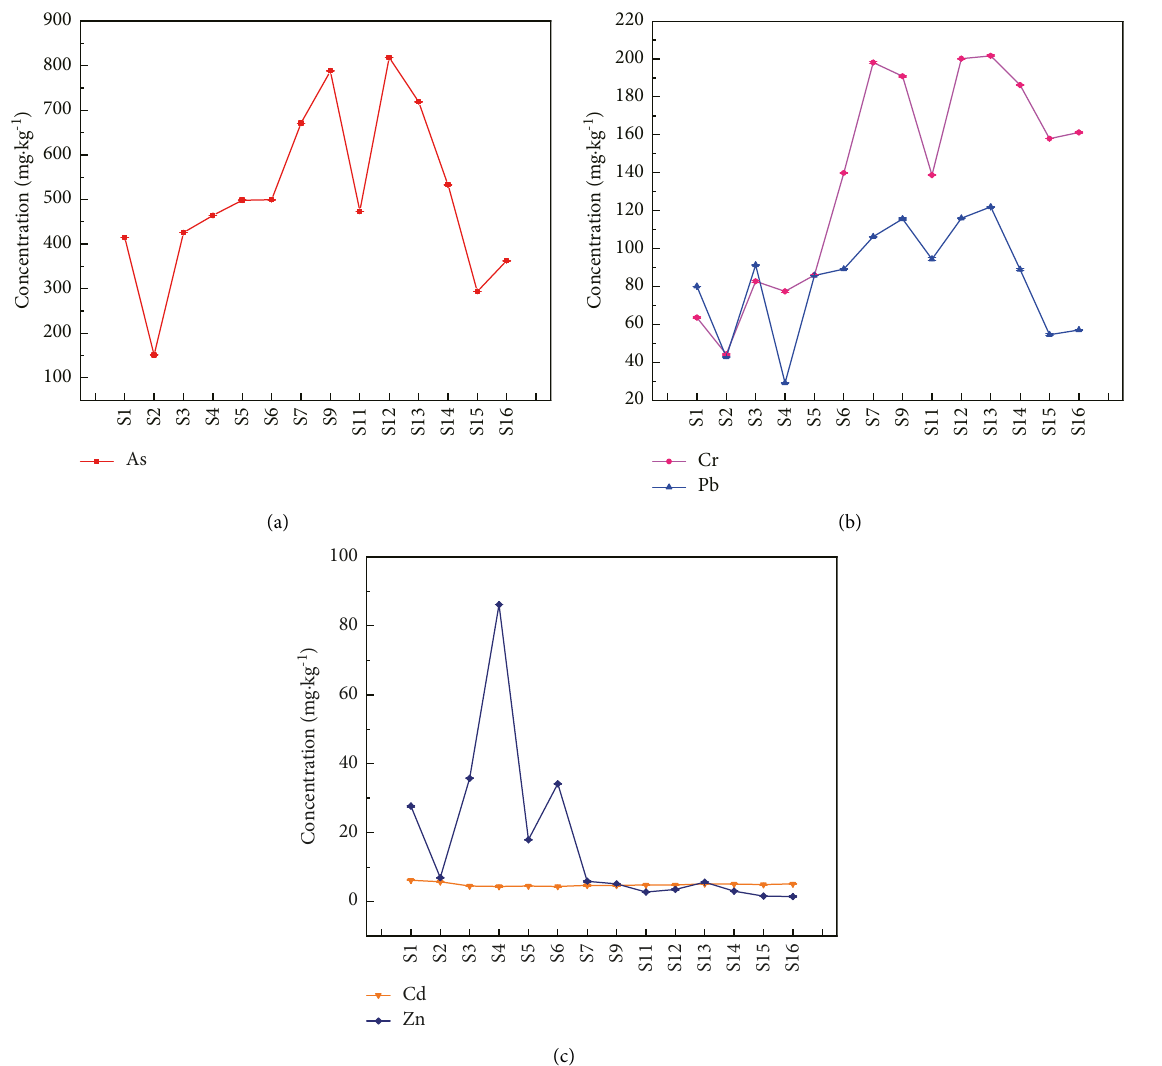
Figure 2: Variation of heavy metals concentrations in the sediments. (a) As; (b) Cr, Pb; (c) Cd,